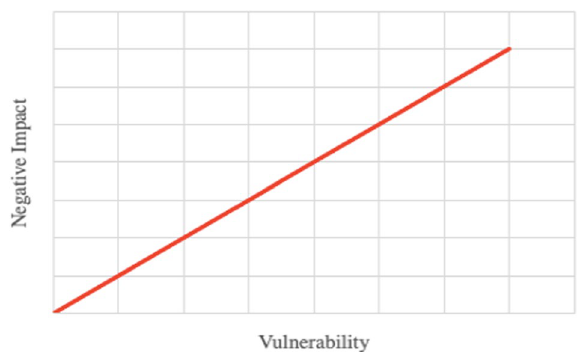
Fig. 2 Impact and vulnerability scale for the use of artificial intelligence to manage